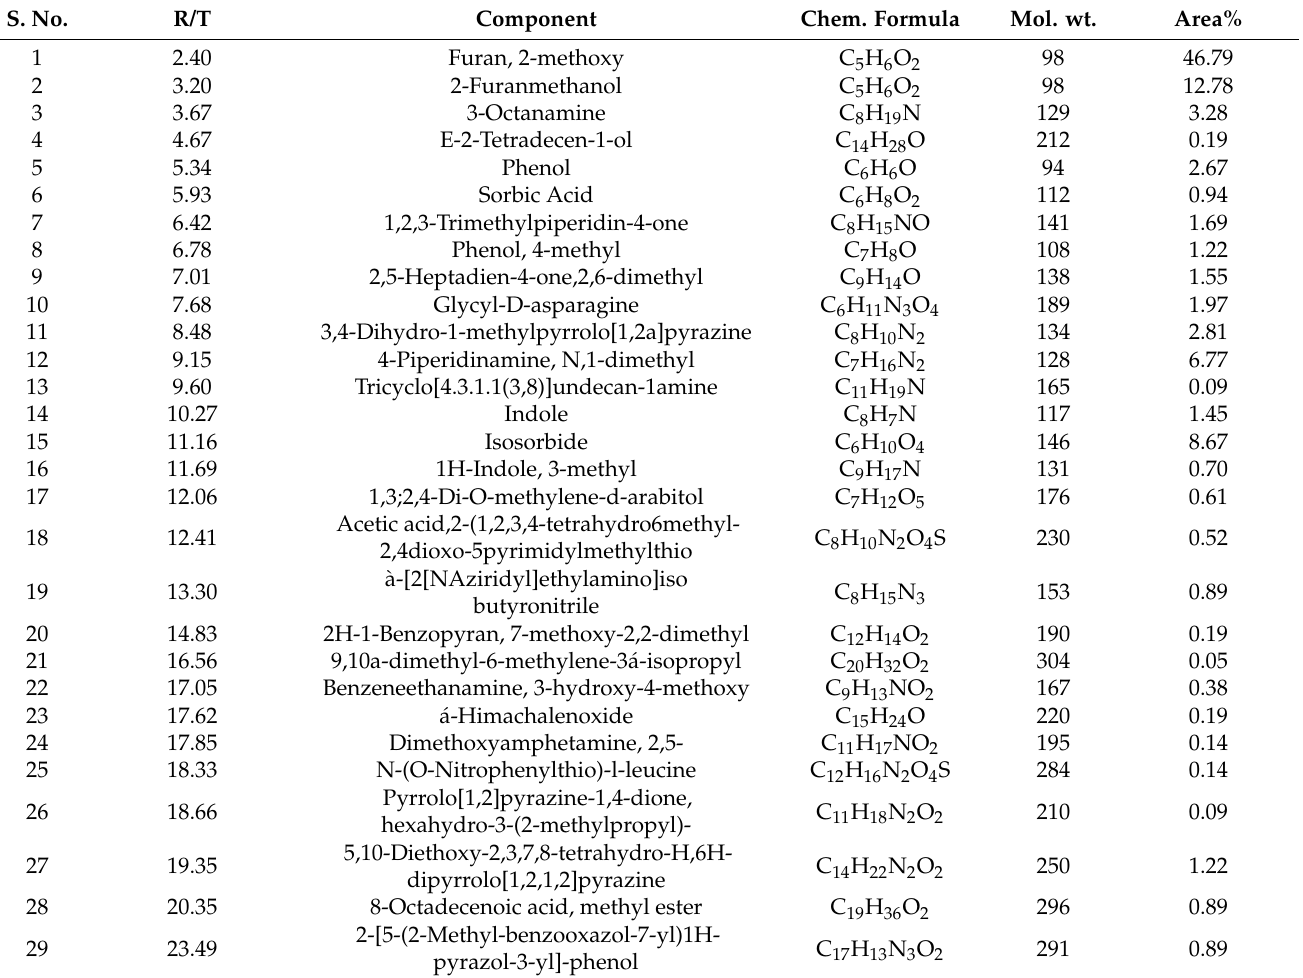
Table 2. Compounds detected in bio-oil obtained from karanja seed press cake without catalyst.